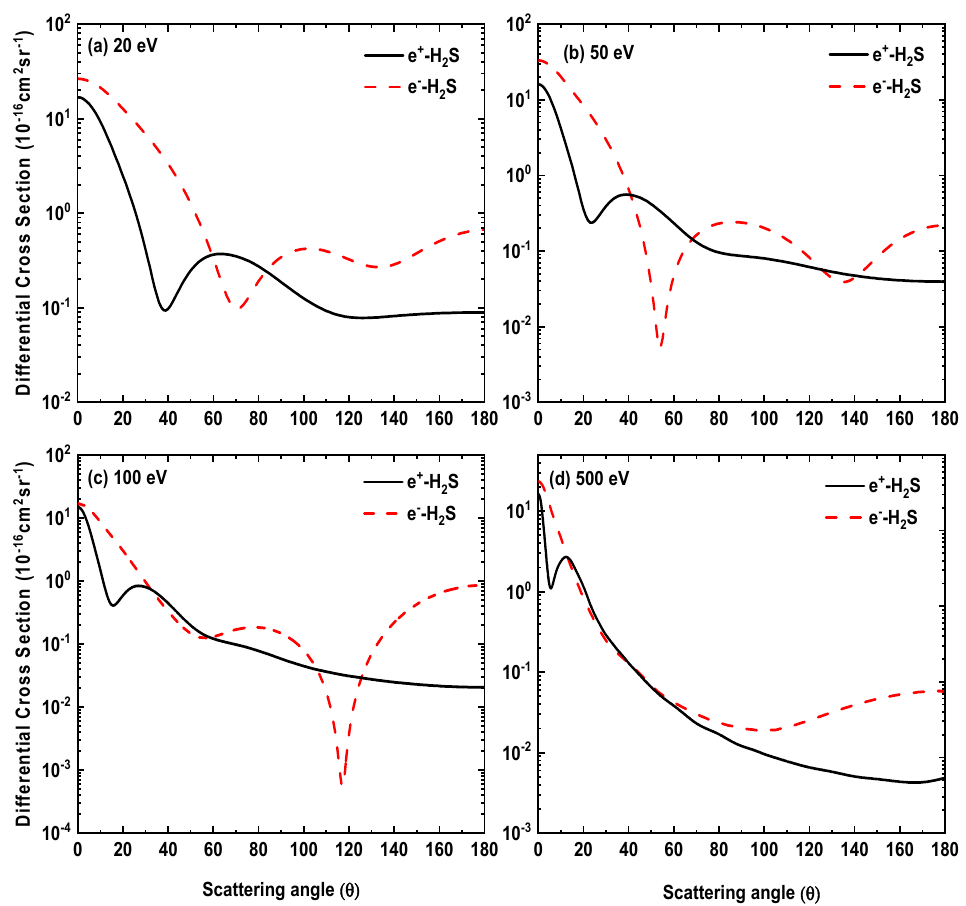
Figure 8. Comparison of differential cross sections for positron and electron scattering from H 2 S at incident projectile energies ( a ) 20 eV, ( b ) 50 eV, ( c ) 100 eV and ( d ) 500 eV.